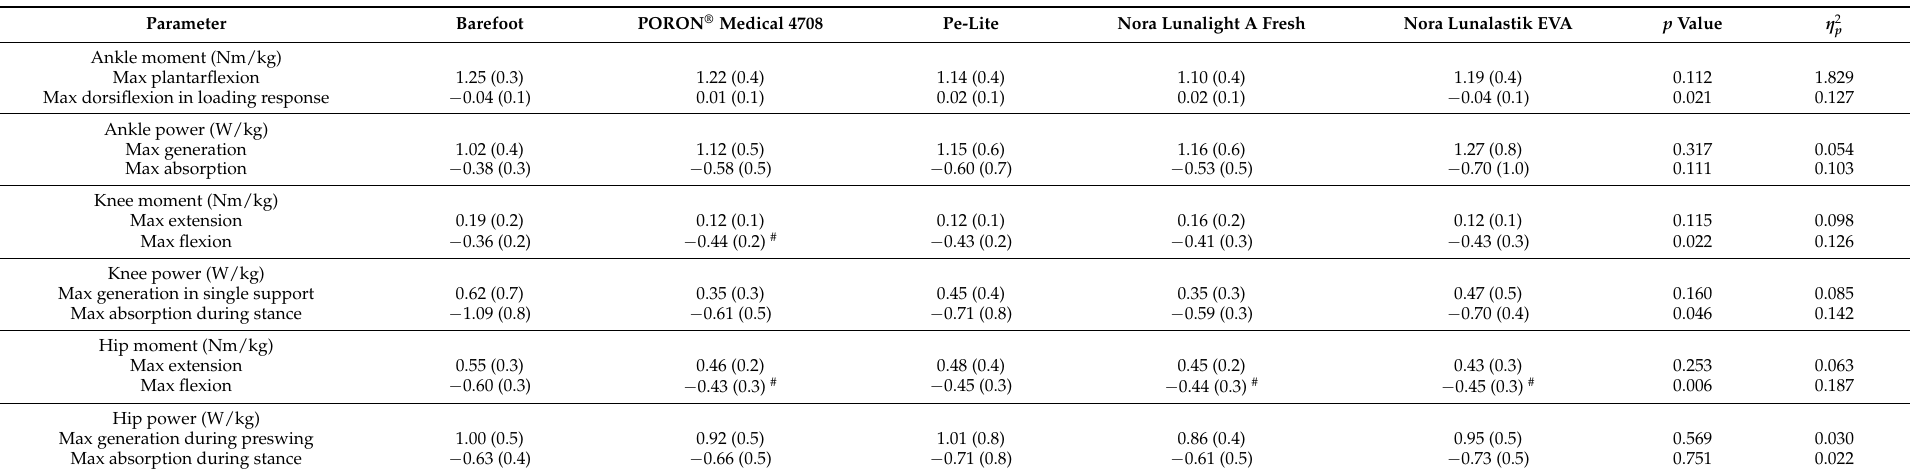
Table 3. Statistical results for kinetics parameters with and without insoles (mean